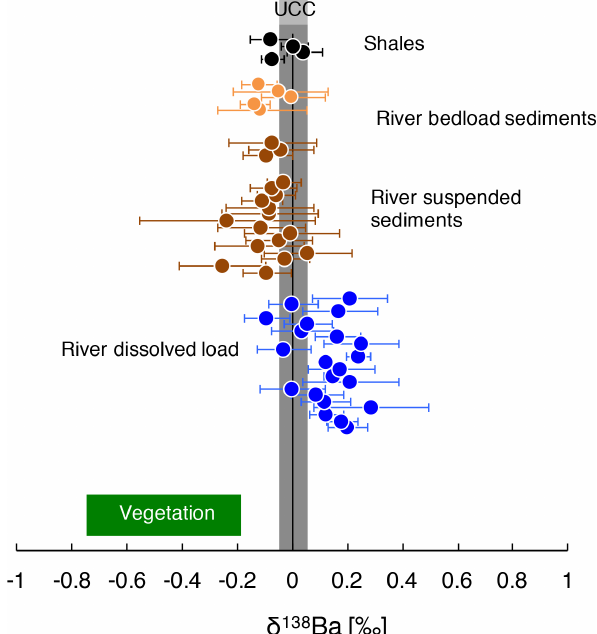
Figure 2. δ 138 Ba of the river dissolved load, river sediments, and shale rocks from the Amazon Basin. The composition of vegeta- tion collected over a soil profile in Hawaii (Bullen and Chadwick, 2016) and the composition of the UCC (upper continental crust; Van Zuilen et al., 2016b; Charbonnier et al., 2018; Nan et al., 2018) reported in the literature are also